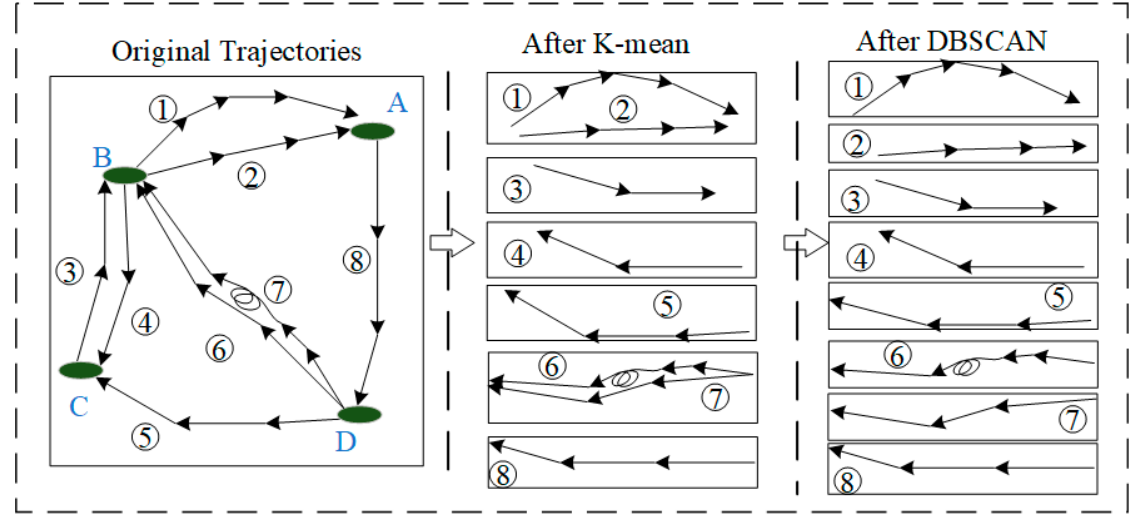
Figure 4. The schematic diagram based on hybrid clustering. The letters A–D represent the desti- nation and departure regions of trajectories whereas the numbers 1-8 represent the reference num- and departure regions of trajectories whereas the numbers 1–8 represent the reference number ber of trajectories. of